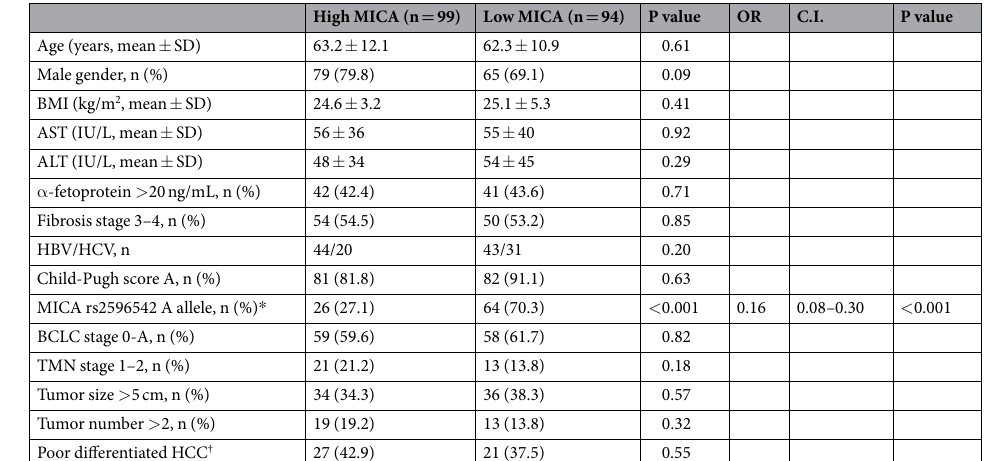
MICA rs2596542 A allele, n (%) *